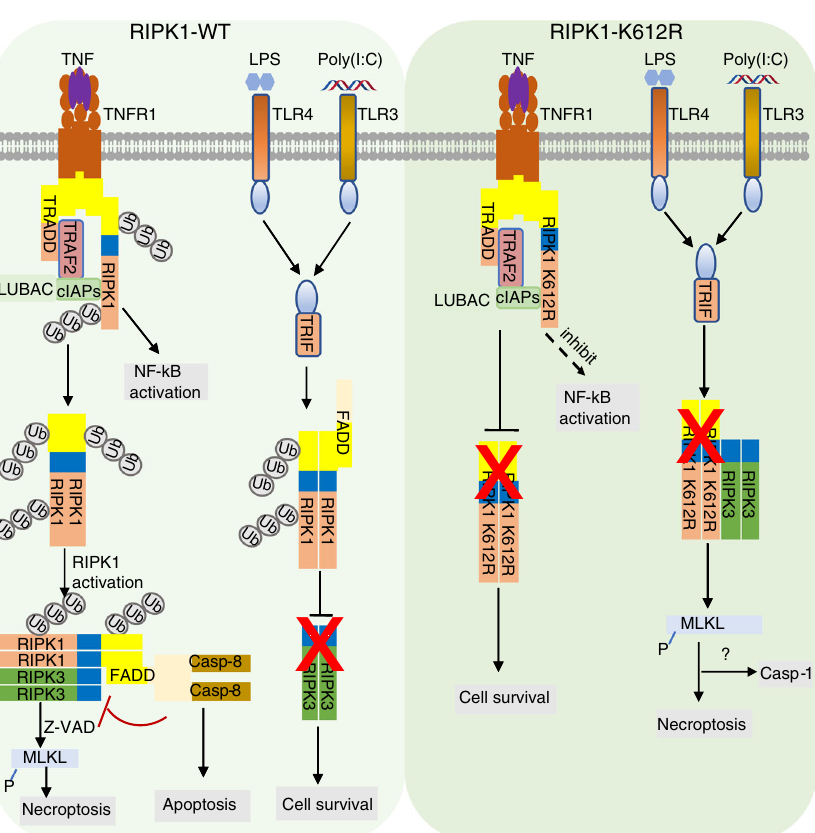
Fig. 8 A model for RIPK1 K612 ubiquitination in TNFR1 and TLR3/4 signalings. In TNF α -stimulated WT cells, RIPK1 is rapidly recruited to TNFR1 by direct binding to the death domain (DD) of TNFR1 or that of TRADD to initiate the formation of complex I. In complex I the ubiquitination of RIPK1 is modulated by multiple E3 ubiquitin ligases such as cIAP1/2 and LUBAC complex. Ubiquitination of RIPK1 mediates NF- κ B activation. Ubiquitination of RIPK1 K612 modulates overall patterns of RIPK1 ubiquitination and promotes RIPK1-RIPK1 and RIPK1-TNFR1 interaction mediated by its DD, which leads to its activation and interaction with FADD/Caspase-8 to mediate RDA or with RIPK3 to mediate necroptosis when caspase-8 is inactivated. K612R mutation reduces the recruitment of RIPK1 and inhibits the activation of RIPK1 upon stimulation of TNFR1 by TNF α . RIPK1 K612R mutation inhibits cell death induced by TNF α through disrupting RIPK1 dimerization and RIPK1-TNFR1 interaction mediated by DD domain. In LPS or Poly (I:C)-stimulated WT cells, RIPK1 and RIPK3 interact with TRIF which regulates the activation of RIPK1 and RIPK3. Ubiquitination of RIPK1 K612 promotes RIPK1 ubiquitination, dimerization and interaction of RIPK1 with FADD, which in turn recruits FADD to suppress necroptosis and caspase-1 activation by restricting RIPK3 activation in response to TLR3 and TLR4. RIPK1 K612R mutation disrupts the interaction of RIPK1 and FADD to promote RIPK3-dependent necroptosis and in fl ammation induced by LPS or